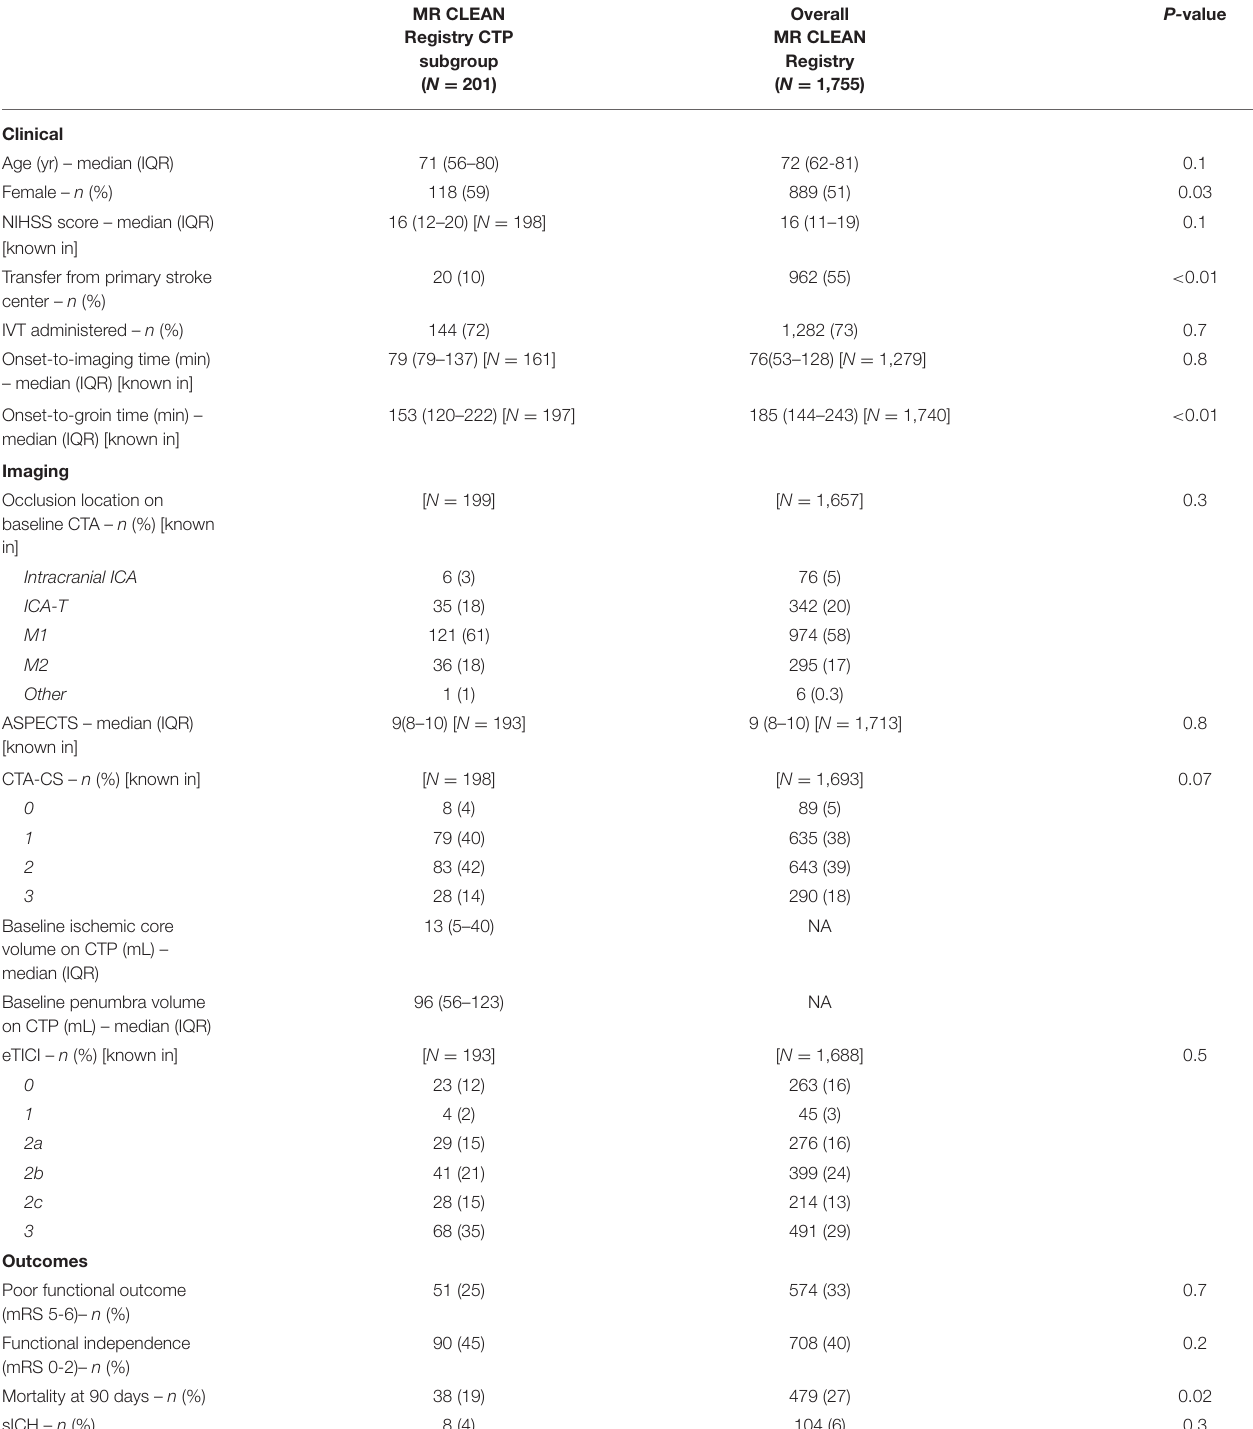
TABLE 1 | Baseline characteristics and outcome of the MR CLEAN Registry CTP subgroup compared to the overall MR CLEAN Registry